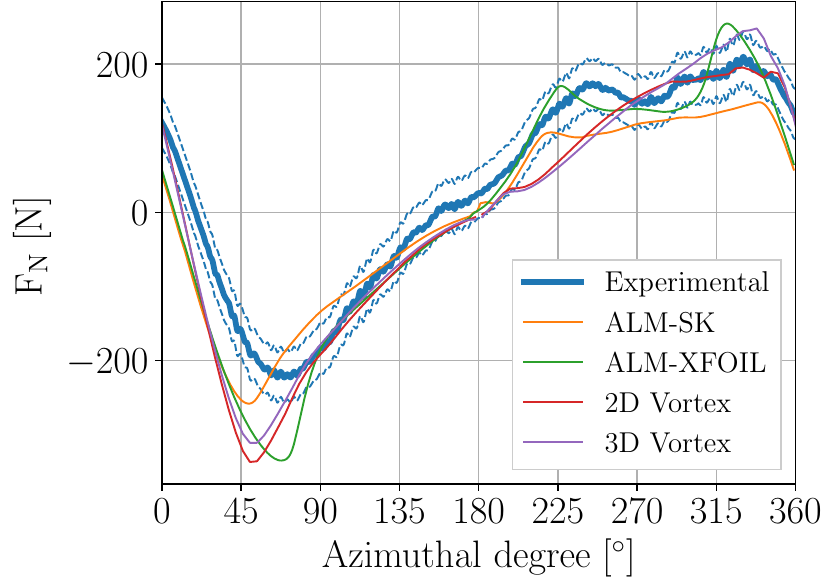
Figure 6. The normal force response at λ =